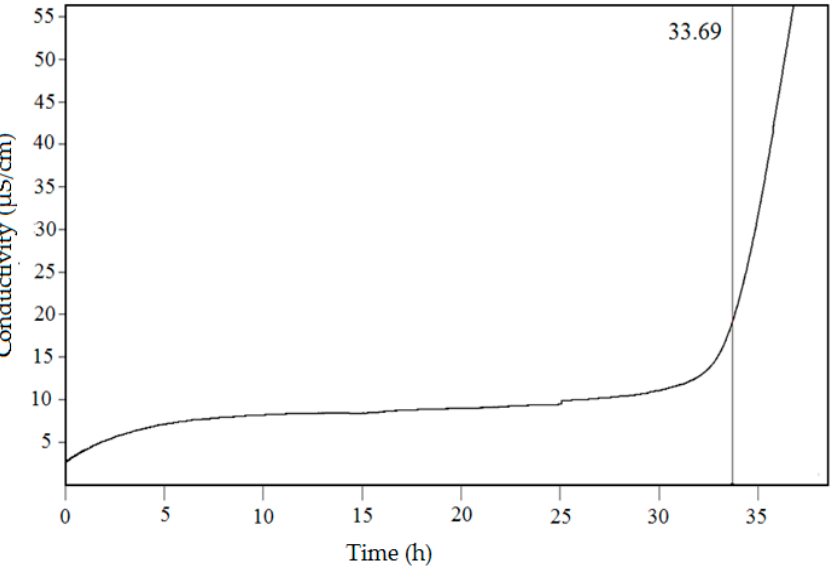
Figure 1. Conductivity versus time determined by the Rancimat method. Oxidation stability of oils at 110 °C. The induction time of babassu oil was 33.69 h.